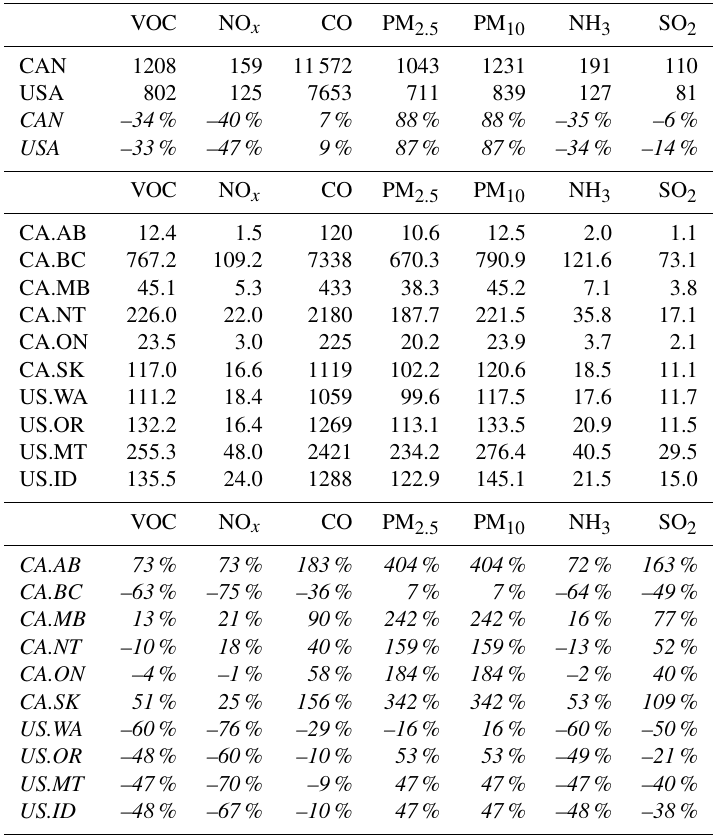
Table 5. Total fire emissions (kilotonnes) in Canada, the US, and selected provinces and states with high fire activity from FireWork-Ops for the July–September 2017 period and percentage differences (in italics) for